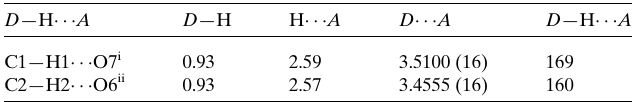
Table 1 Hydrogen-bond geometry (A˚ , (cid:4) ).